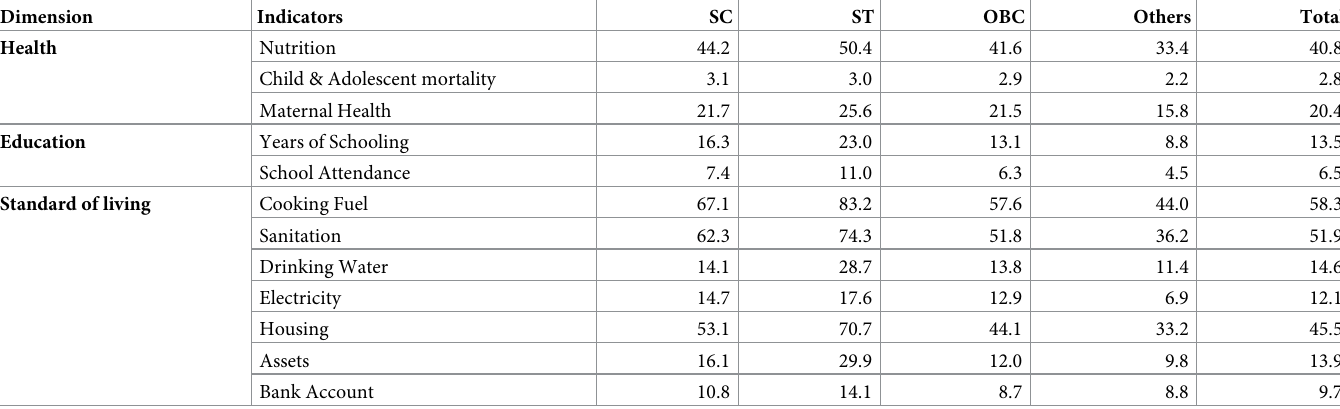
Table 2. Percentage of people deprived in each indicator of the MPI by social groups in India.